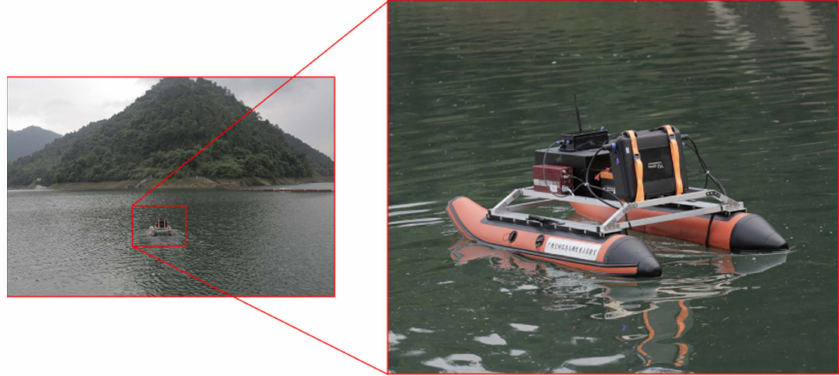
Figure 28. The experiments under reservoir